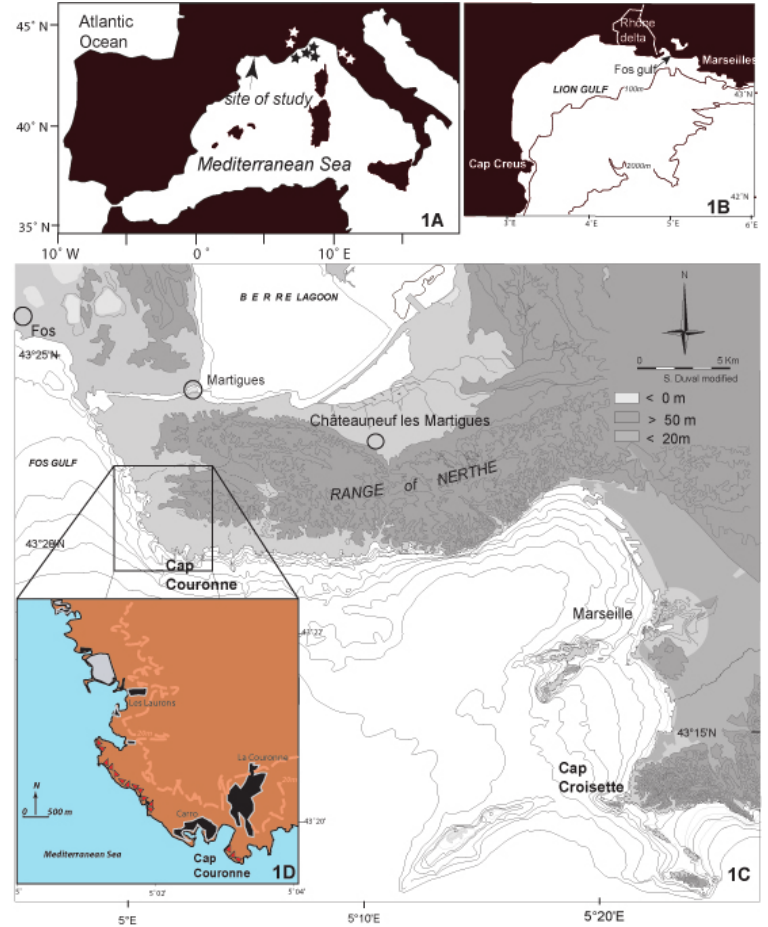
Fig. 1. Location map of the study area. (A) The arrow indicates the zone of study and stars indicate epicentres of earthquakes induced tsunamis on the french coast of metditerranean (from Pelinovski et al., 2001, modified). (B) The studied zone is very exposed to the waves and the swells from the West and the southwest. ( B and C ) The studied coast is protected by the cape Couronne and the cape Croisette of the swells from east and southest. (D) The red triangles localize the zones of